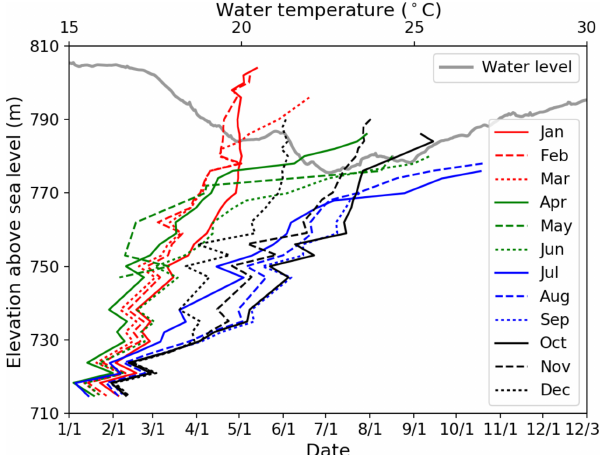
Figure 4. Measured monthly water temperature profile for Nuozhadu Reservoir in the year 2015. The light gray line indicates the water level variation throughout the